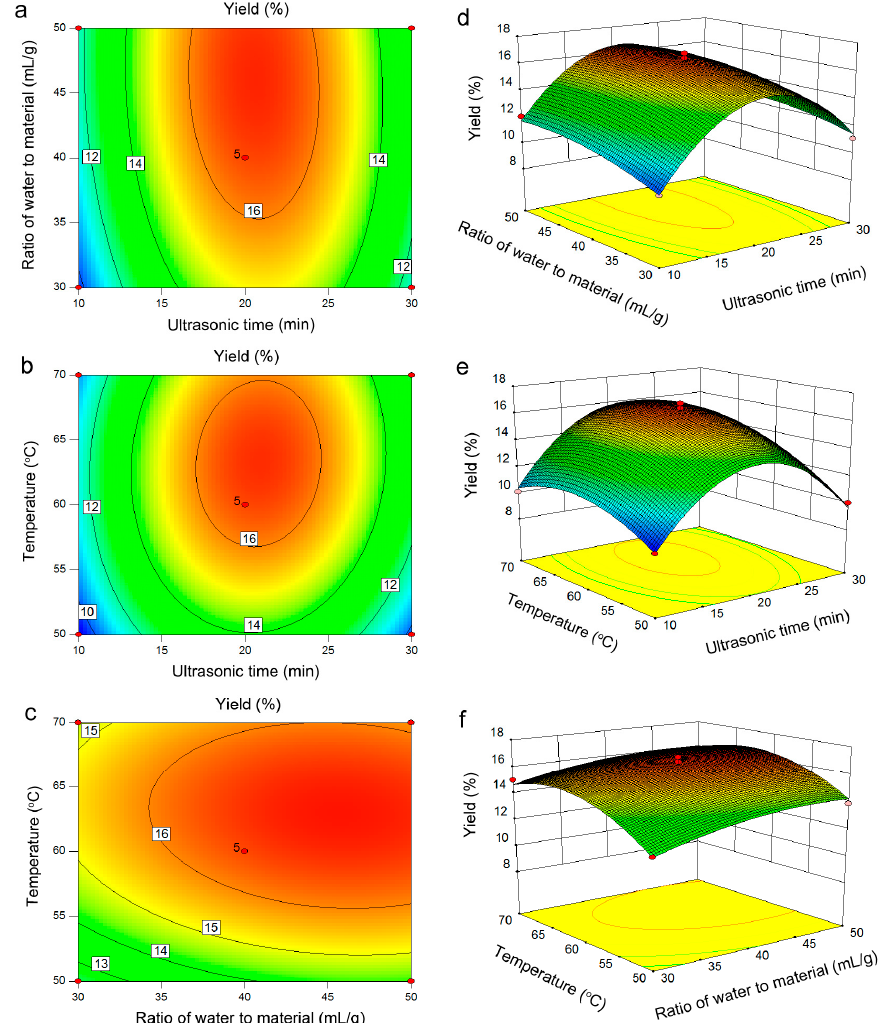
Figure 2. Contour plots ( a – c ); and 3D response surface plots ( d – f ) showing the interaction effects on the extraction yield of PRM; ( a , d ), ratio of water to material and ultrasound exposure time; ( b , e ), ultrasound extraction temperature and ultrasound exposure time; ( c , f ), ultrasound extraction temperature and ratio of water to